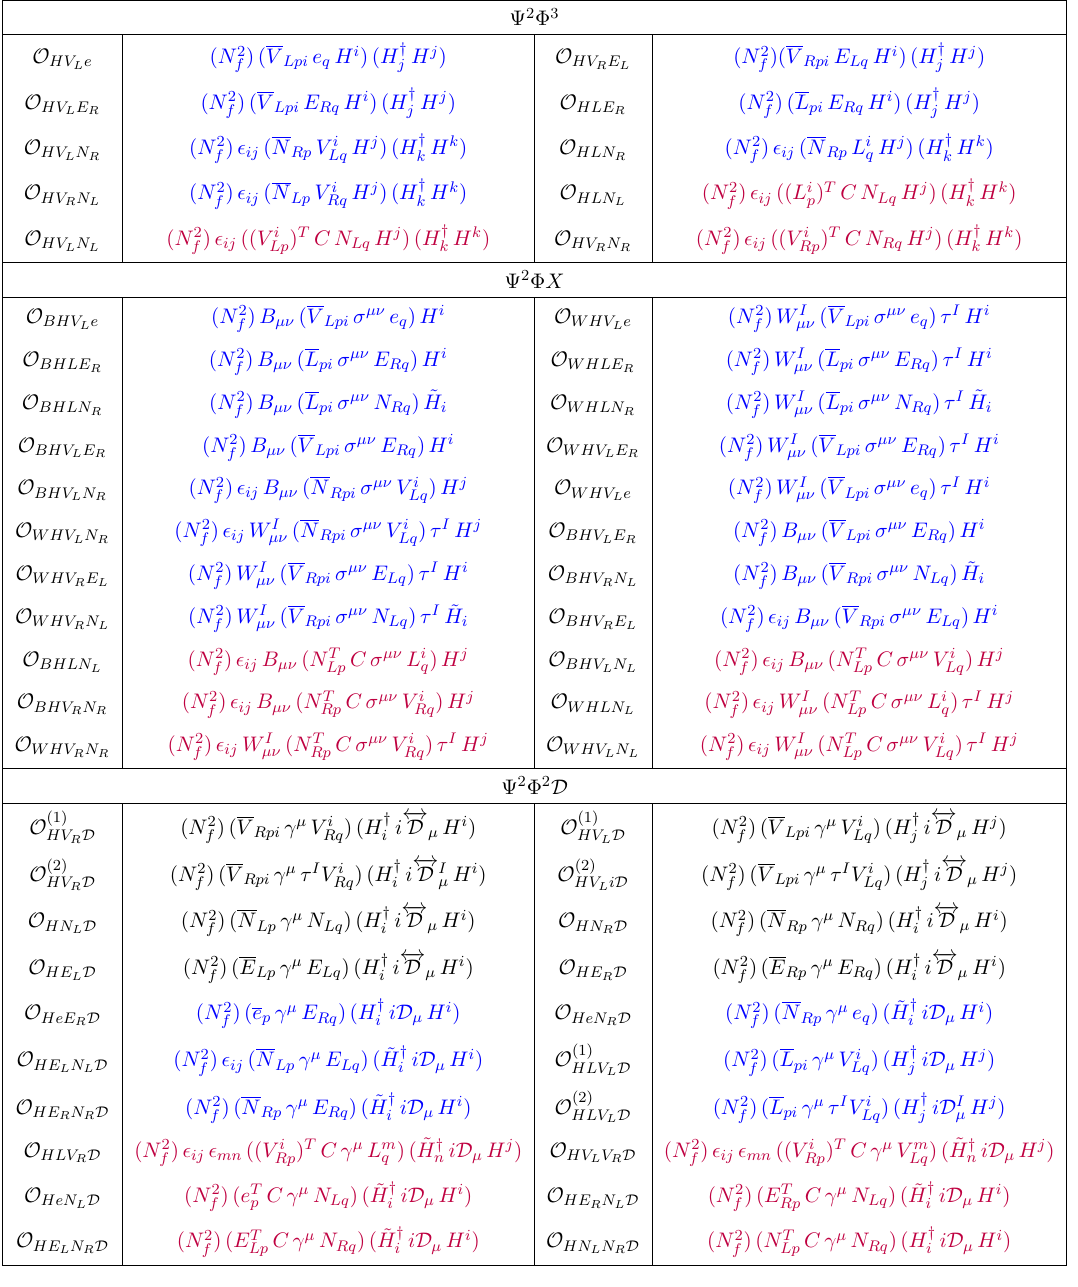
Table 11 . SM extended by Vector-like Leptons ( V L,R , E L,R , N L,R ): additional operators of dimen- sion 6. i, j, m, n are the SU(2) indices and p, q = 1 , 2 , · · · , N f are the flavour indices. τ I ( I = 1 , 2 , 3) is the SU(2) generator. Operators in red violate lepton